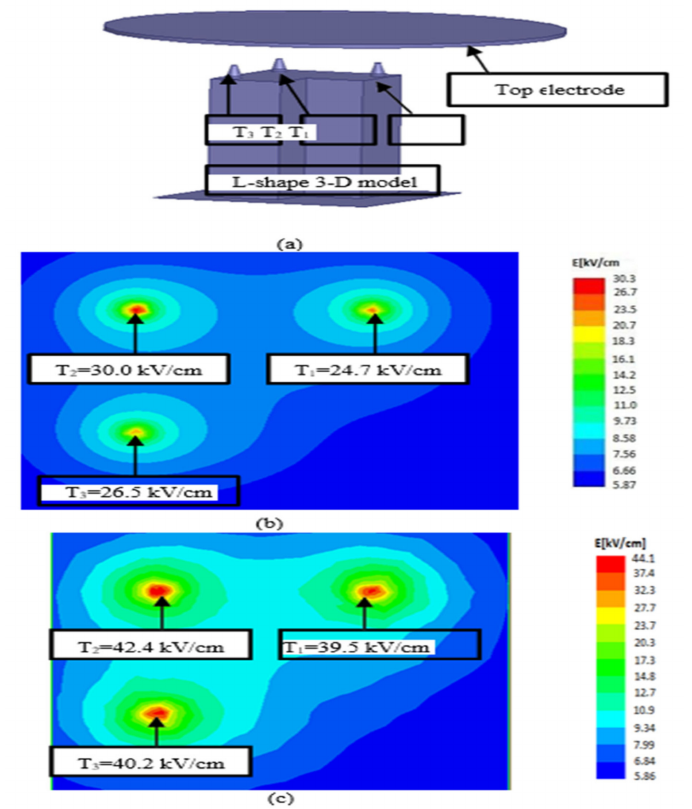
Figure 8. 3-D model-Shape building structure ( a ) Probability of lightning on an L-shape structure: ( b ) field plot without upward leaders, ( c ) field plot with upward